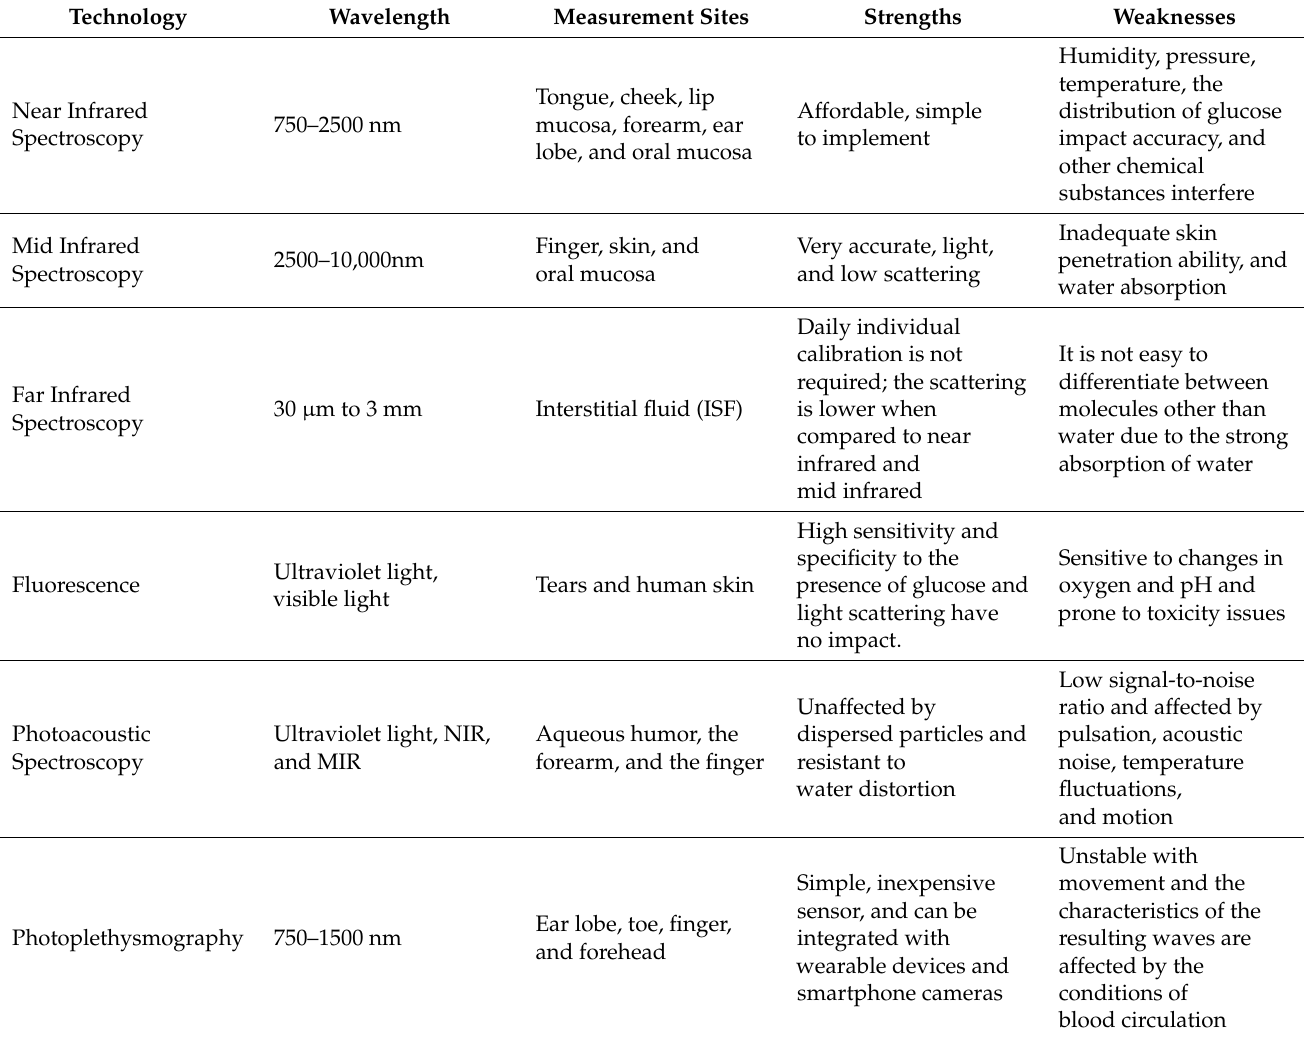
Table 1. Summary of optical technique technology